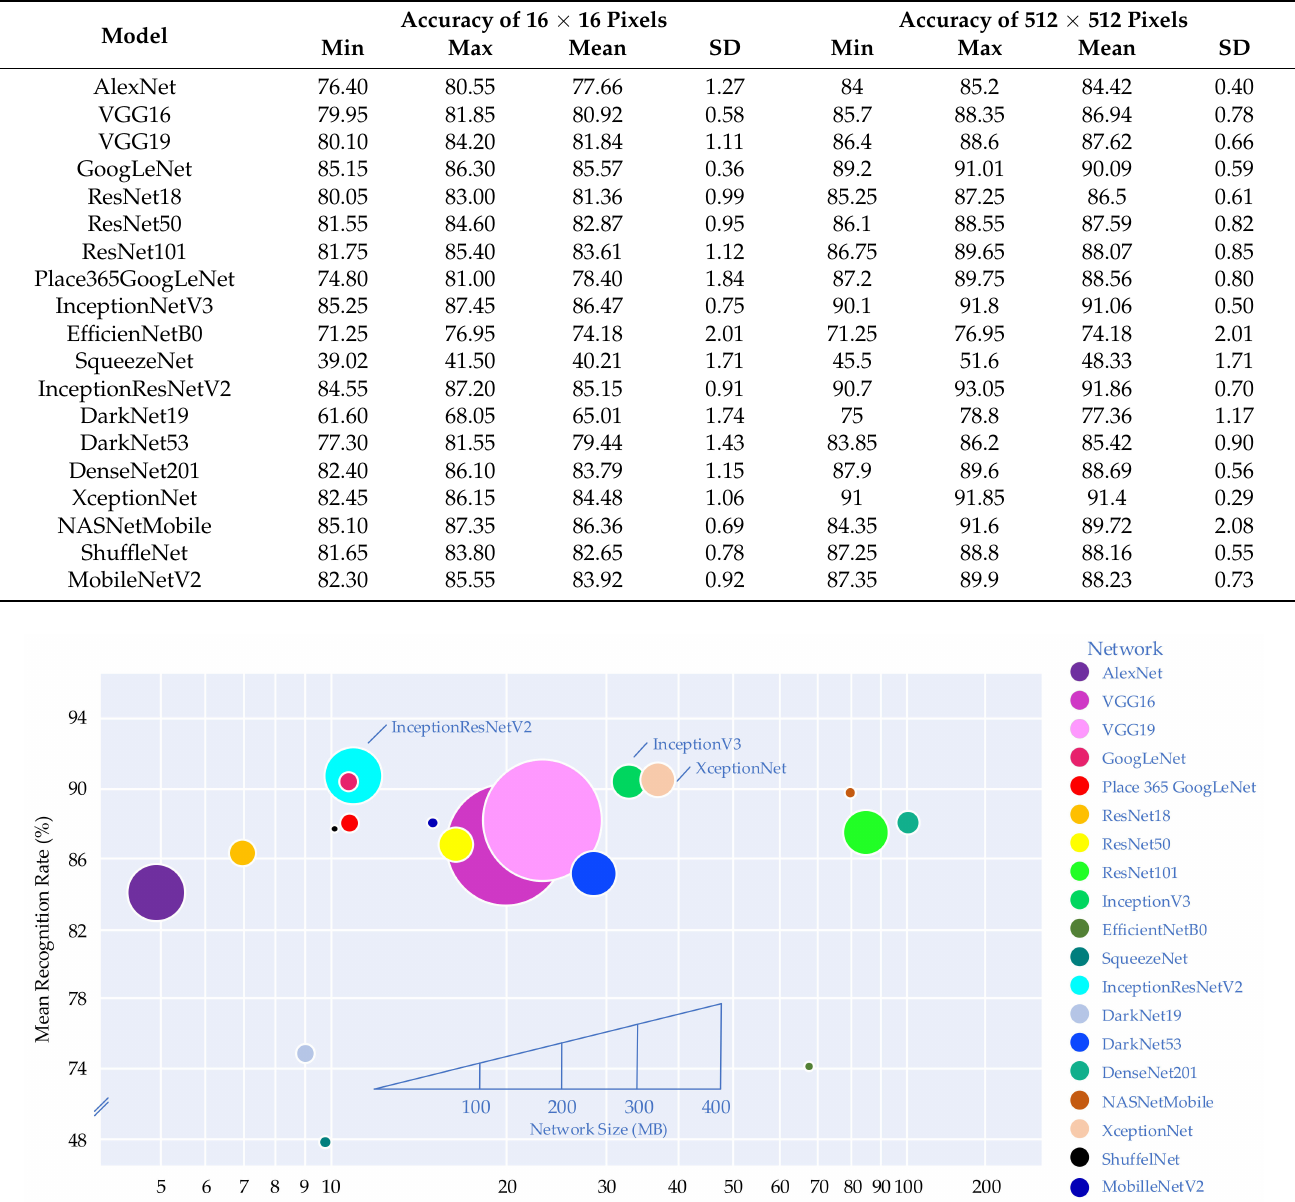
Table 6. The recognition rate of each DCNN from 16 × 16 pixels and 512 × 512 pixels resolution.